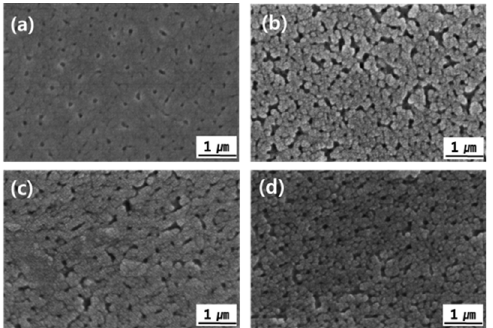
Figure 5. FE-SEM images of AAO film surfaces: ( a ) No, ( b ) 1 mM, ( c ) 2 mM, and ( d ) 3 mM Ce ion.